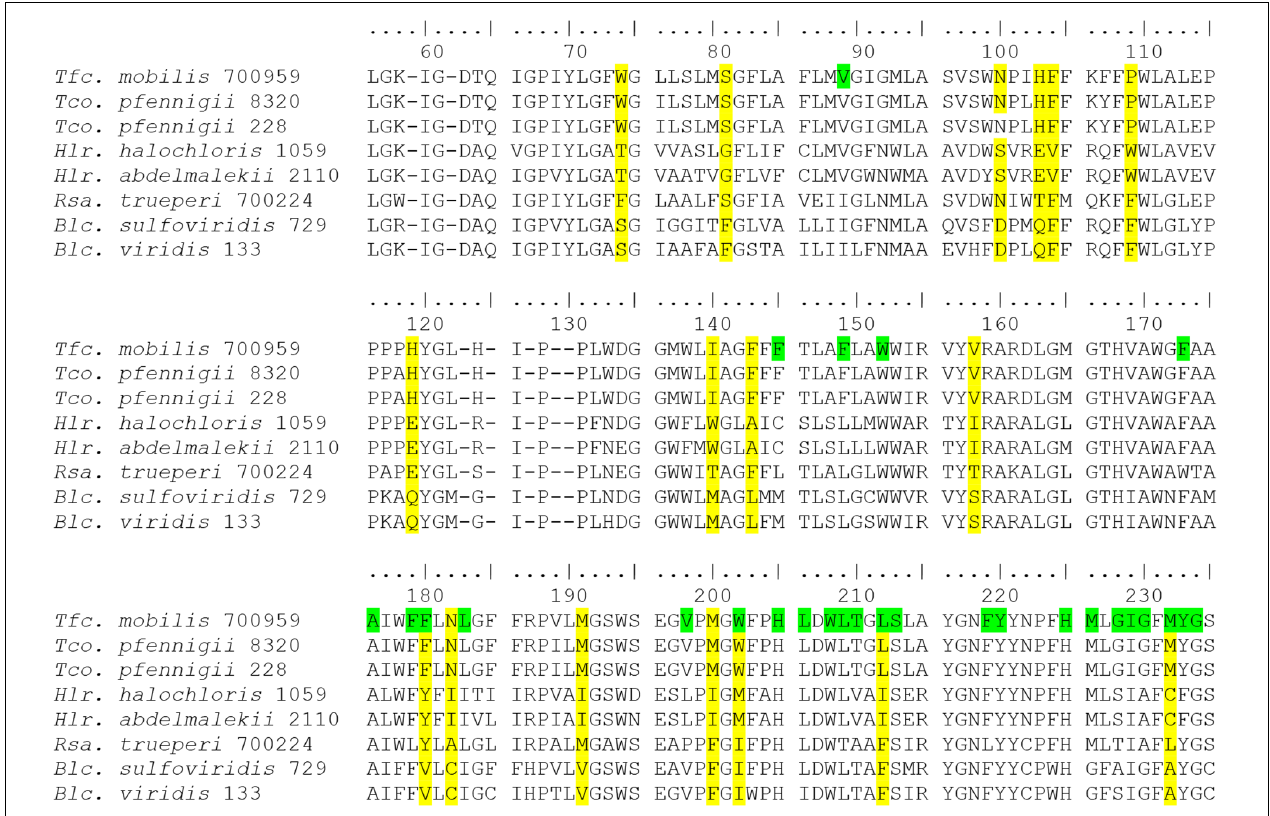
FIGURE 3 | Alignment of PufM sequences (position 55–235) from bacteriochlorophyll- b -containing phototrophic bacteria. Important differentiating amino acids of the three groups are highlighted in yellow, bacteriochlorophyll-binding sites in green (only top line).